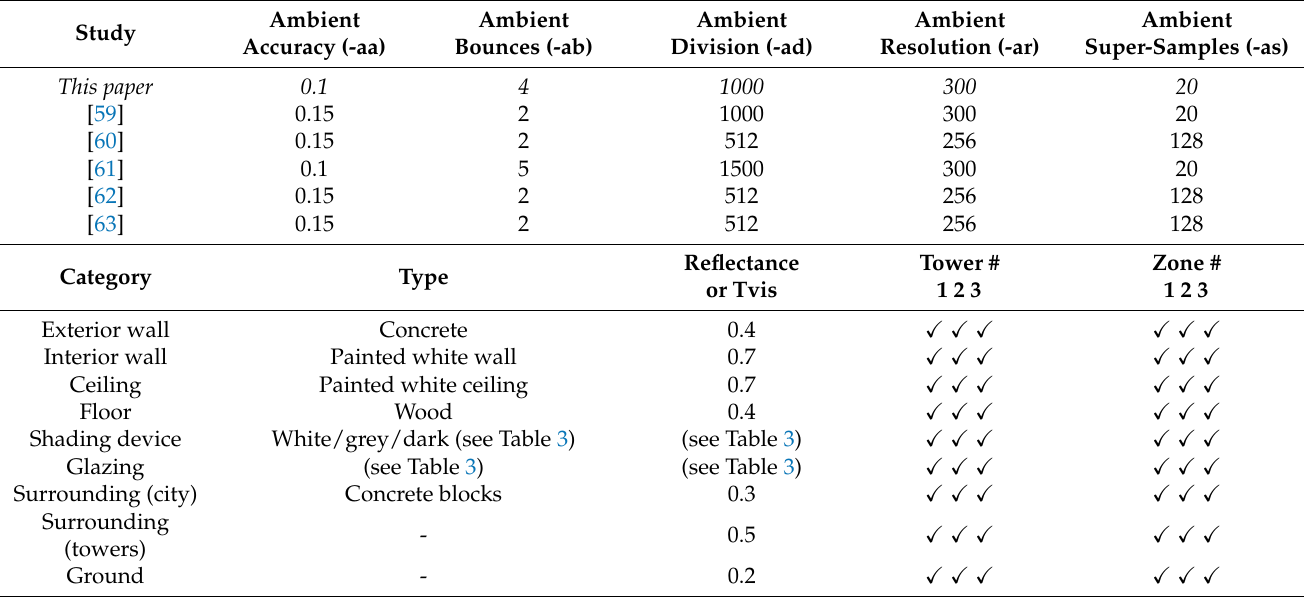
Table 6. Radiance parameters and material properties of the daylight